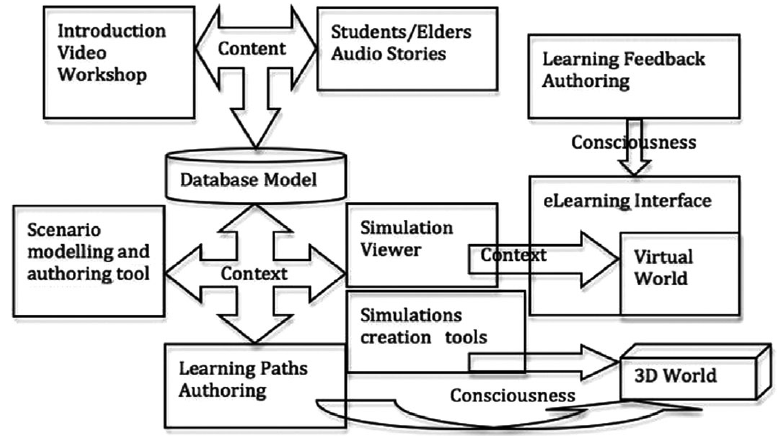
Architecture for learning design with separation into Model View Control (MVC)